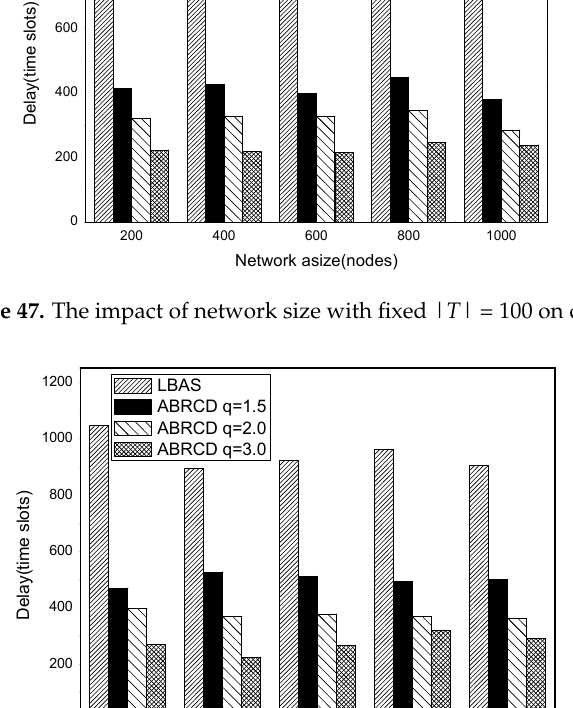
Figure 48. The impact of network size with fixed | T | = 120 on delay.